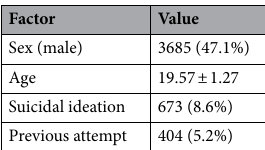
Table 1. General characteristics of the participants (n = 7824). Values were presented as mean ± SD or n (%).